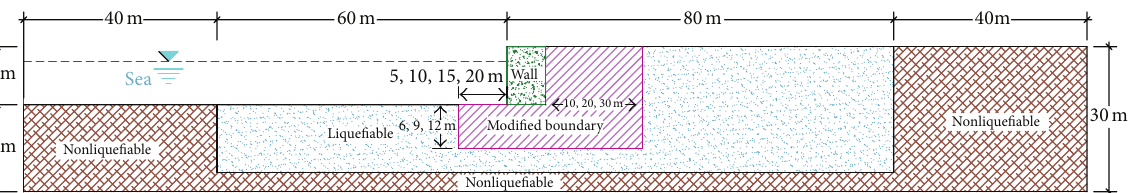
Figure 9: Areas selected to determine the optimum range for the soil